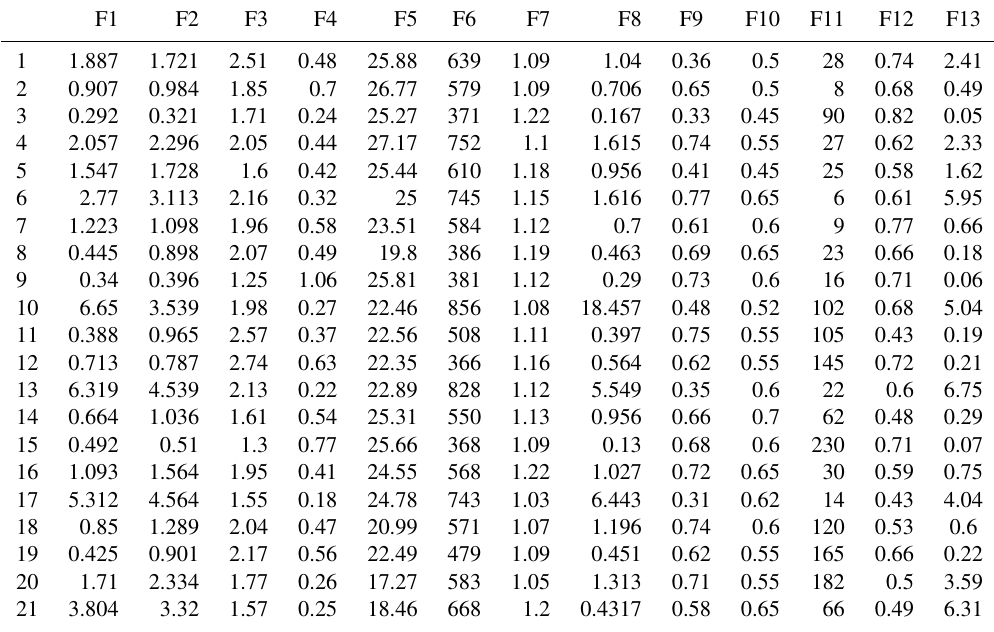
Figure 8. Flowchart used for classification and susceptibility assessment. Table 4. The values for the 13 factors of the 21 debris flow